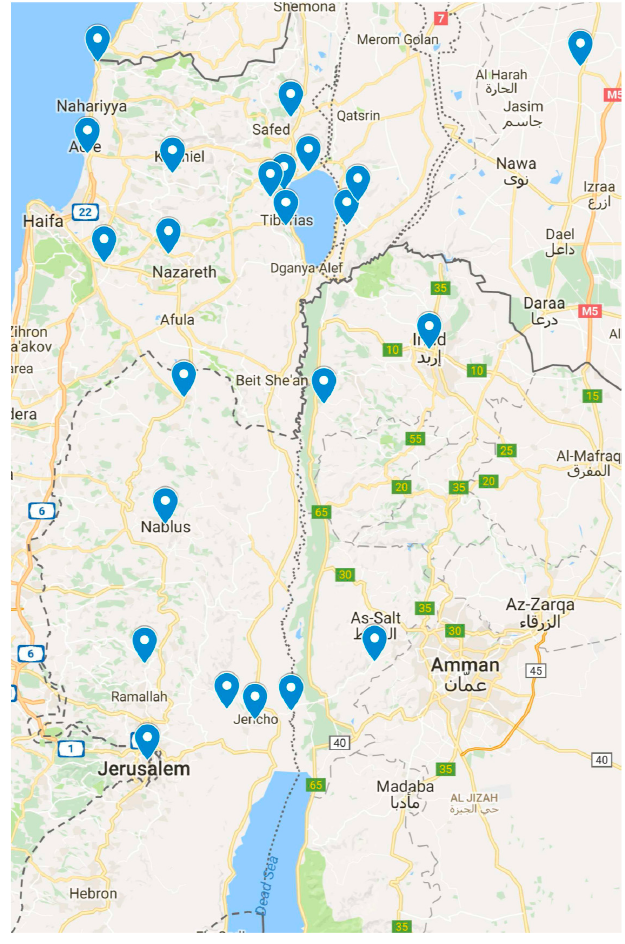
Figure 1. Localities of the Holy Land allegedly visited by Jesus in days with rain according to the EMV. Scale: 1 cm=10 km. Table 2. Number of rainy days described in the years of Jesus’ public life, as they are deduced by the astronomical analysis of the EMV for each year and total period. Key: 75/366 means 75 days described out of 366 of Jesus’ public life in year I; 9/75 means 9 rainy days out of 75, etc. The four numbers in